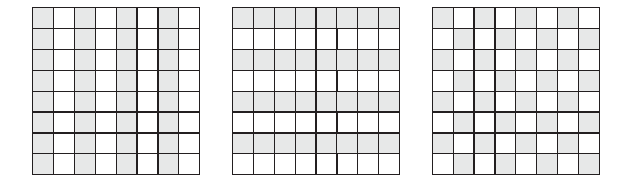
Figure 18: Example of coe ffi cient subsets (marked gray) used for dynamic interframe DCT coding with a limitation to 32 coe ffi cients per subset.